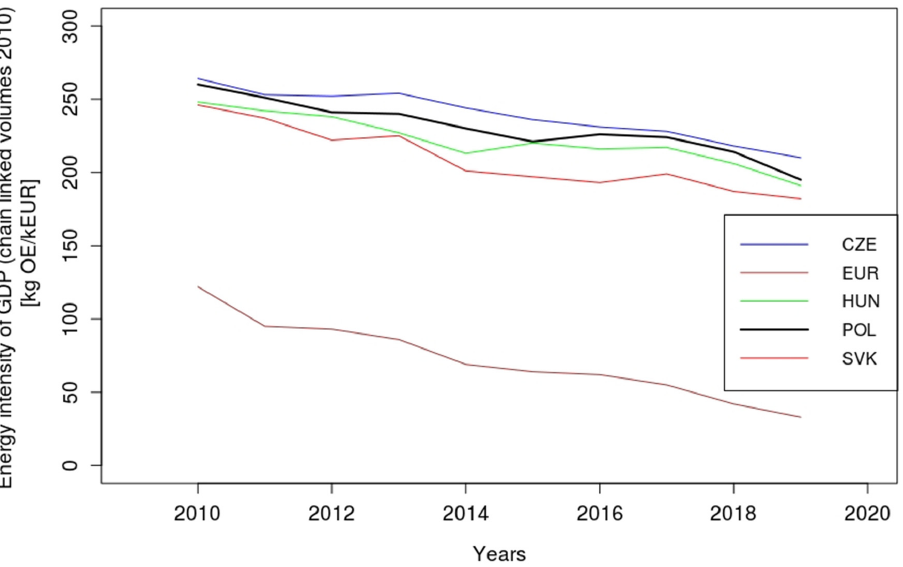
Figure 3. Energy intensity of GDP (2010–2019). Source of data: EUROSTAT [38].